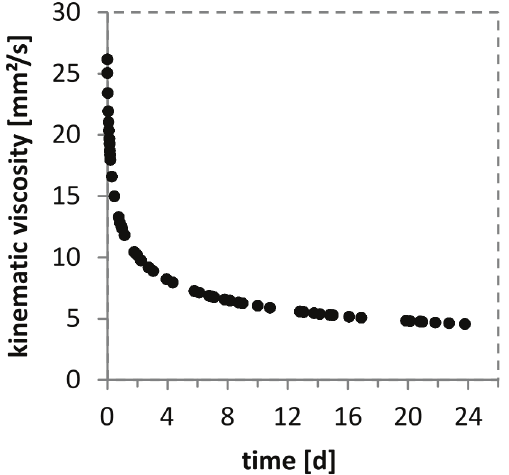
Figure 1. Time dependent, viscometrical tracking of the degradation of a 10 mg/mL chitosan solution (0.1% AcOH, DA 42%) with 1.5 μg/mL lysozyme at 37